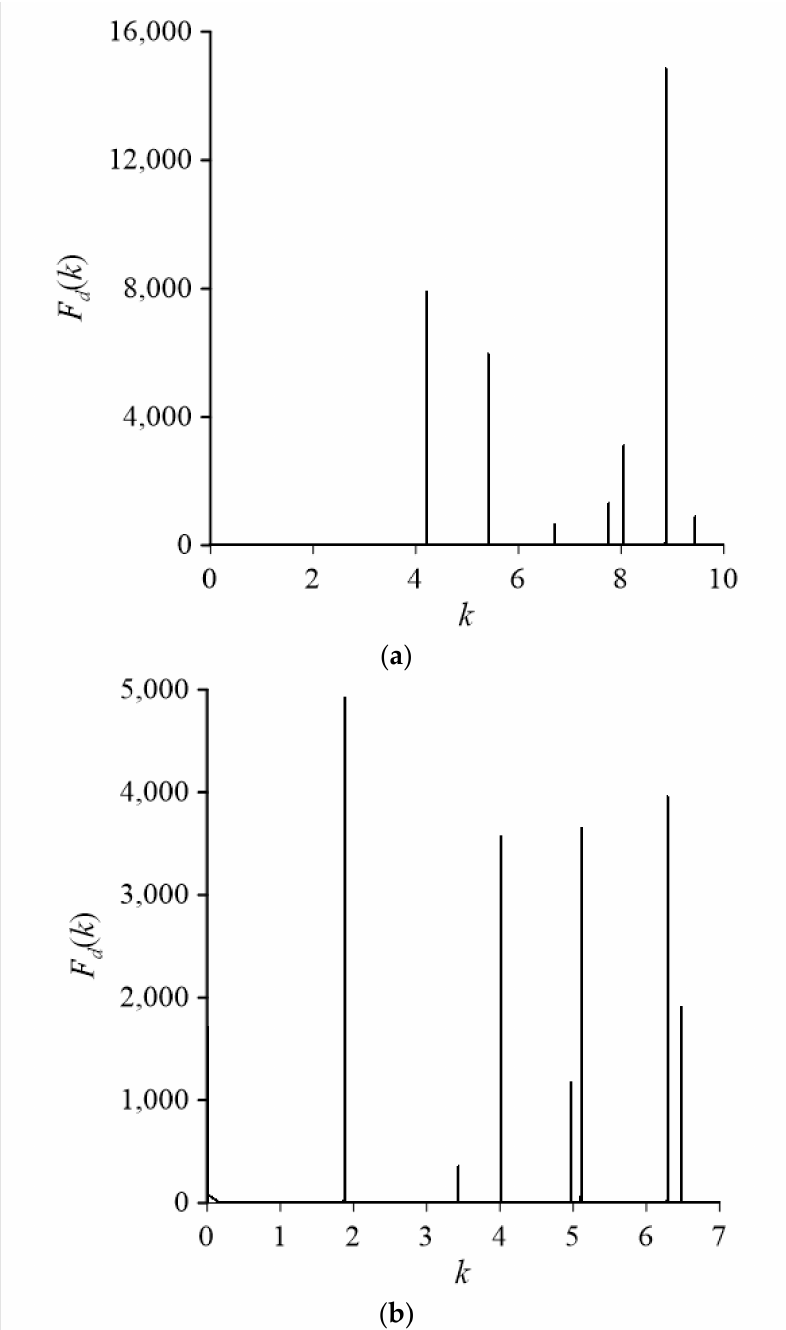
Figure 3. Resonance curves for the elliptic waveguide for ( a ) TM mode and ( b ) TE